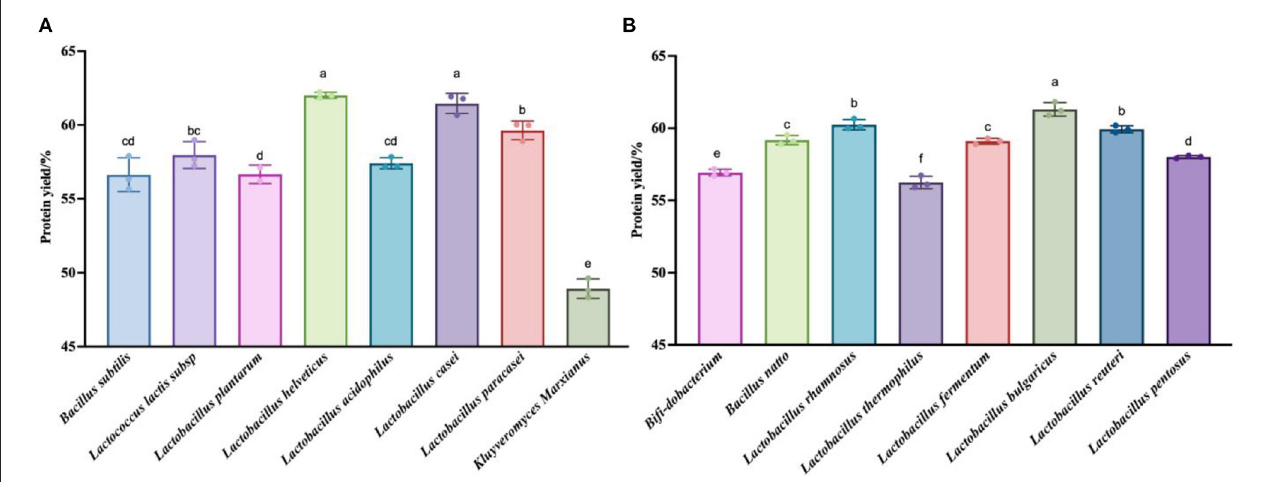
FIGURE3 Detection results of the protein content in the fermentation residue. (A) Hydrolysis degree produced by fermentation of quinoa by 8 strains ( Bacillus subtilis , Lactococcus lactis subsp , Lactobacillus plantarum , Lactobacillus acidophilus , Lactobacillus casei , Kluyveromyces Marxianus ) at their respective optimal fermentation time. (B) Hydrolysis degree produced by fermentation of quinoa by 8 strains ( Bifi-dobacterium , Bacillus natto, Lactobacillus rhamnosus , Lactobacillus thermophilus , Lactobacillus fermentum , Lactobacillus bulgaricus, Lactobacillus reuteri , Lactobacillus pentosus ) at their respective optimal fermentation time. The values are presented as the mean of three replicates ± standard deviation. Dip-value ≤ 0.05.